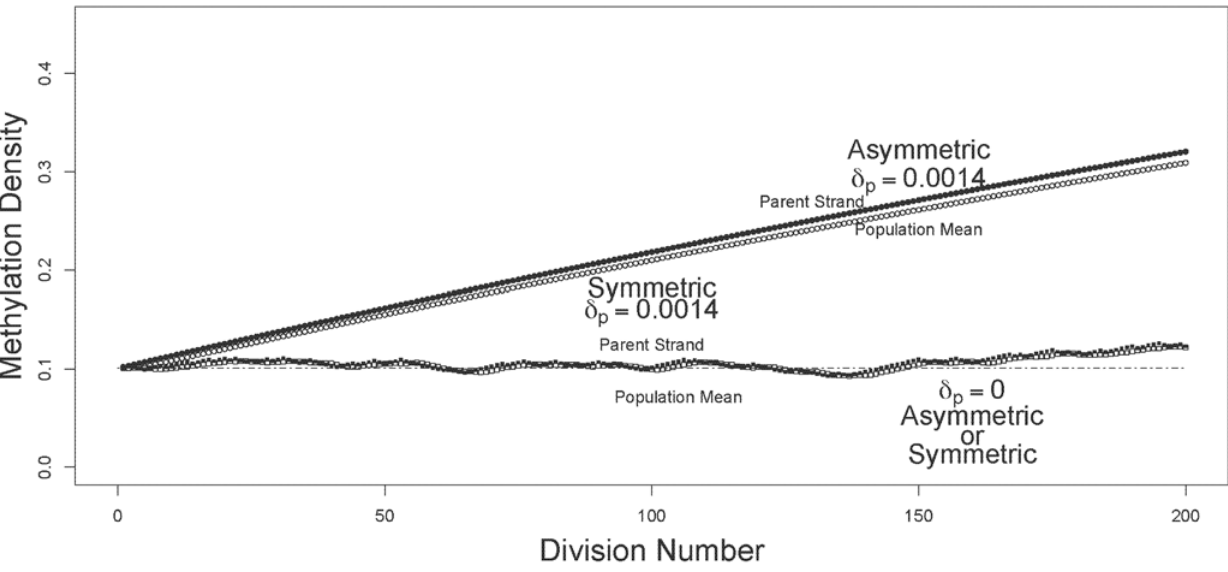
Figure 3. Trajectories of methylation densities under asymmetric or symmetric strand segregation, with low initial methylation density. The oldest-parent strand and the population-mean methylation densities (filled and open circles, respectively), are shown for simulations run under asymmetric and symmetric modes of strand segregation (circles and squares, respectively). The simulations shown here used a starting methylation density of m ~ 0 : 1 . For the scenarios with parent strand de novo methylation, densities were calculated with m ~ 0 : 975 , and d p ~ d d ~ 0 : 0014 . Under asymmetric strand segregation, these parameter values lead to monotonic increases in population-mean and oldest-parent strand methylation densities. Under symmetric strand segregation, these parameter values lead to population-mean and oldest-parent strand DNA methylation densities that are dynamic about the starting value. With no parent-strand de novo methylation ( d d ~ 0 : 1, d p ~ 0 ), densities were unchanged under both symmetric and asymmetric strand segregation (dashed line). Note that the range and scale of the y-axis differ between Figure 2 and Figure